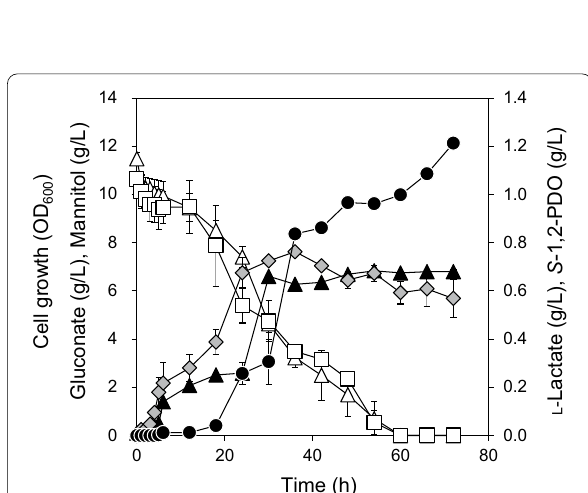
a Yield (%, g/g-glucose